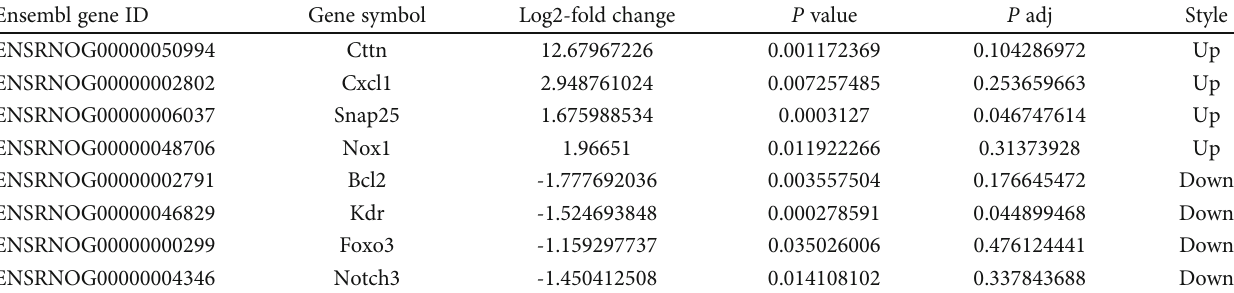
Table 1: The partially DEGs from RNA-Seq [MCAO(Saline)/MCAO(PN)].